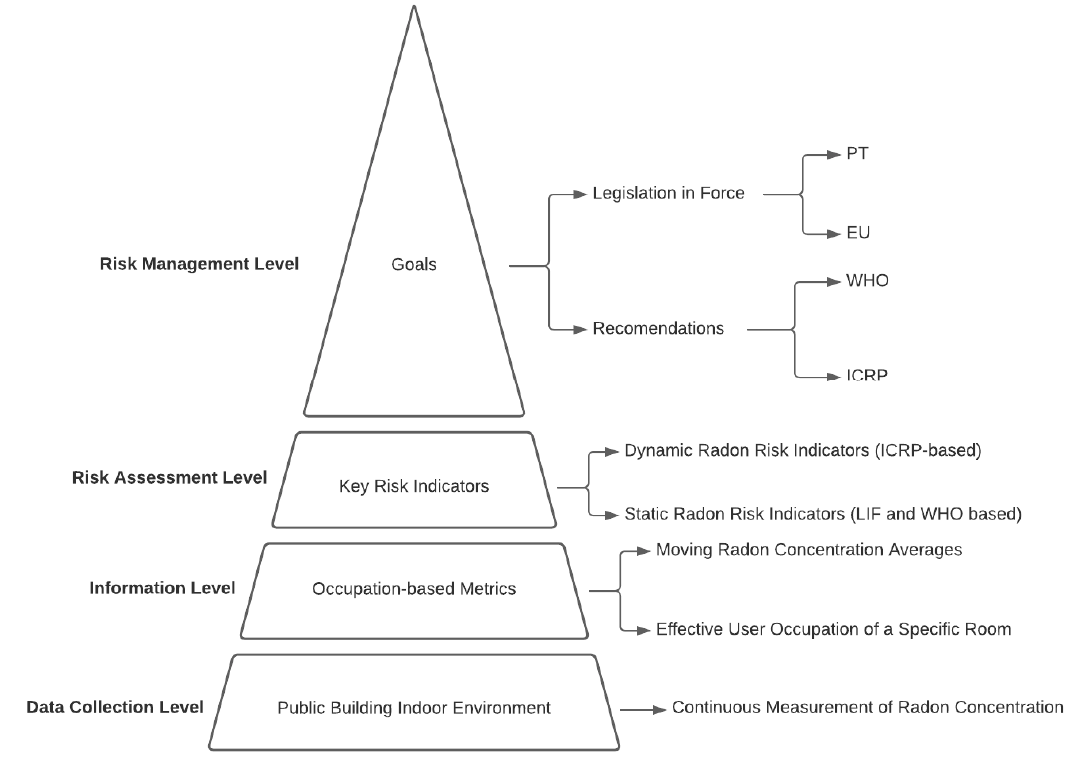
Figure 2. Indoor Radon risk management strategy (PT—Portugal; EU—Europe; WHO—World Health Organization; and ICRP—International Commission on Radiological Protection).